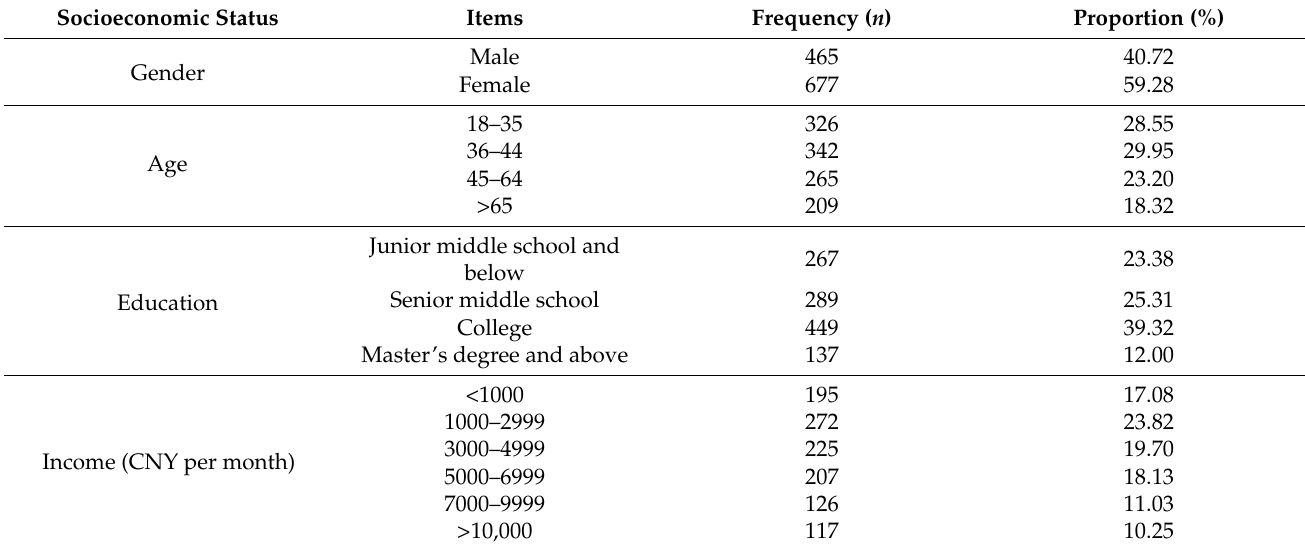
Table 2. Distribution of the socioeconomic status characteristics of the